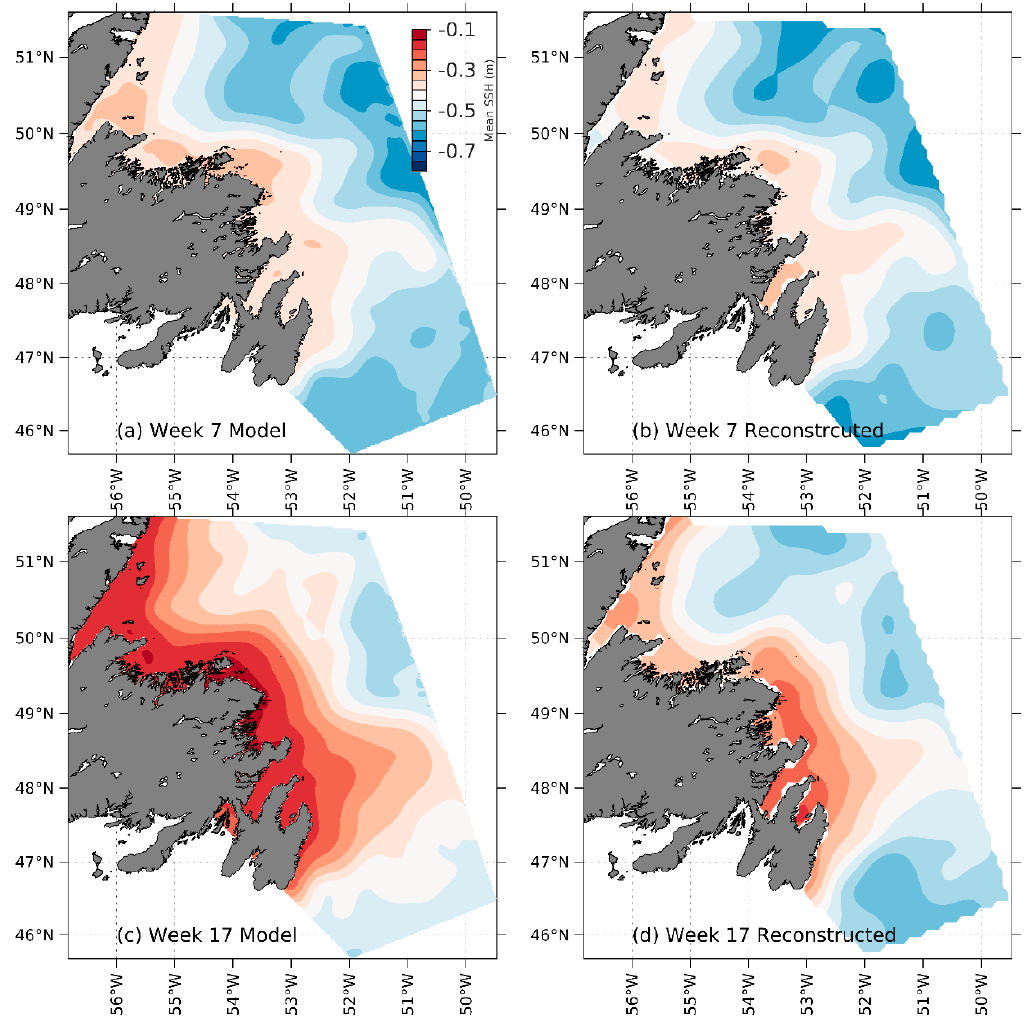
Figure 5. The model SSH for ( a ) the 7th week and ( c ) the 17th week and the mapped SSH using optimal interpolation for ( b ) the 7th week and ( d ) the 17th week.